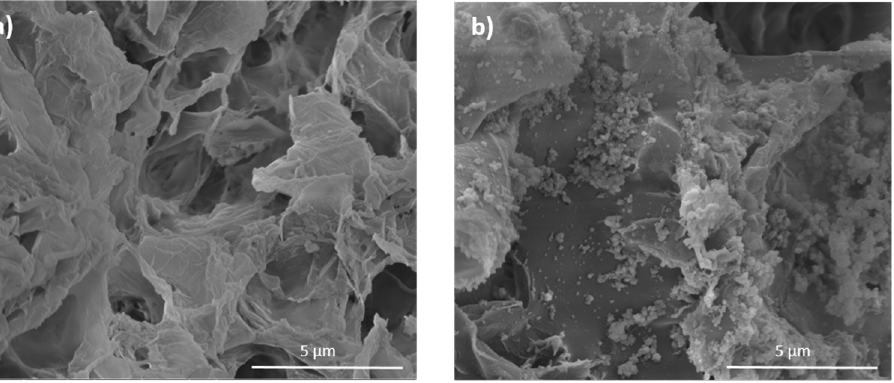
Figure 8. SEM micrographs of PLLA/CPO aerogels without ( a ) and with ( b ) PDA coating.